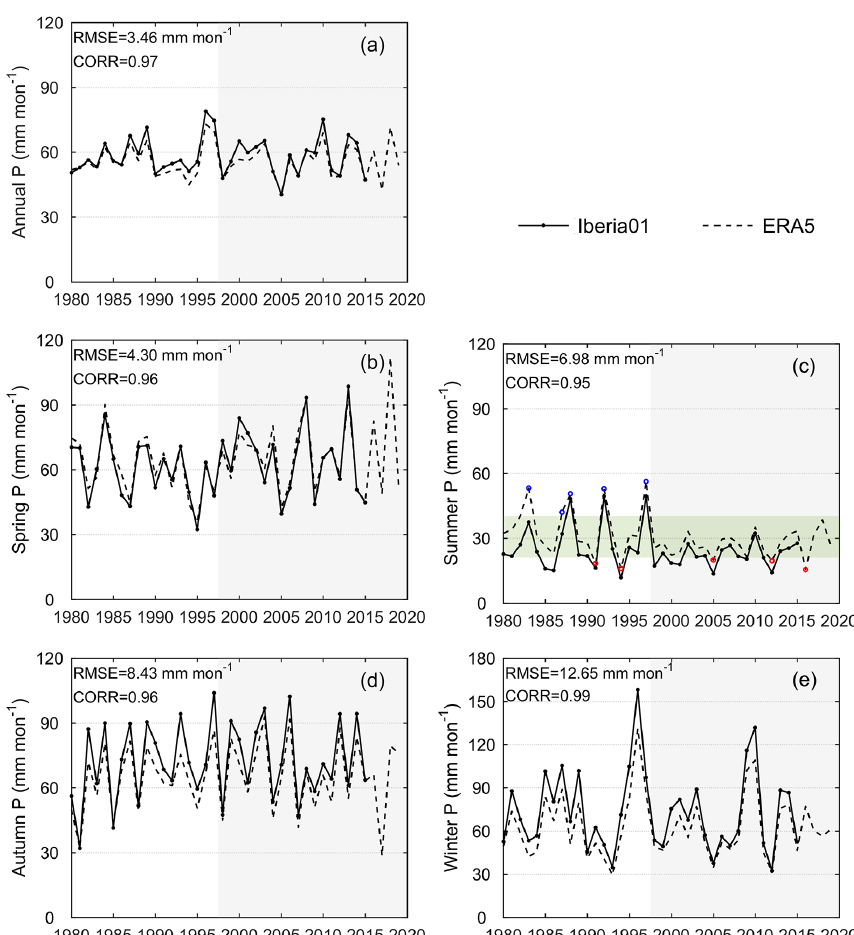
Figure 2. Variations of IP (a) annual precipitation, (b) spring (March, April and May), (c) summer (June, July and August), (d) autumn (September, October and November) and (e) winter (December, January and February) during 1980–2019. The white shading is for the period 1980–1997 and the gray shading is for the period 1998–2019. The green shading covers the interval of one standard deviation of summer precipitation. The years with summer ERA5 precipitation exceeding the range of the green shading interval are circled in blue and